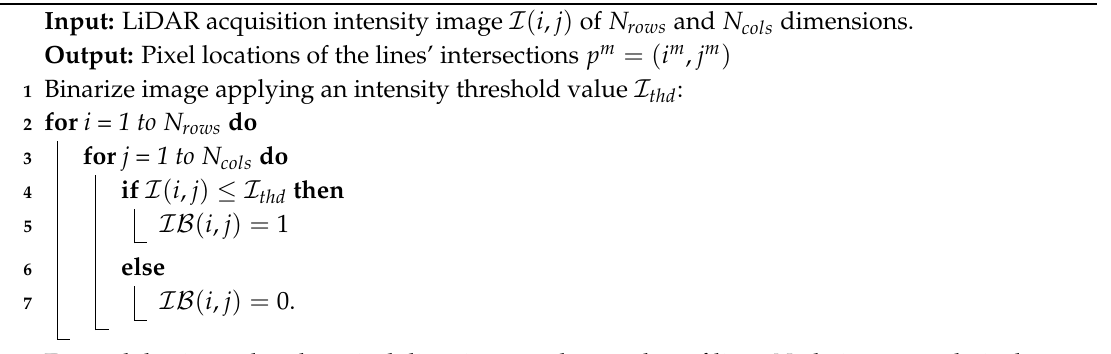
Algorithm 1: Image processing for obtaining the pixel locations of the lines’